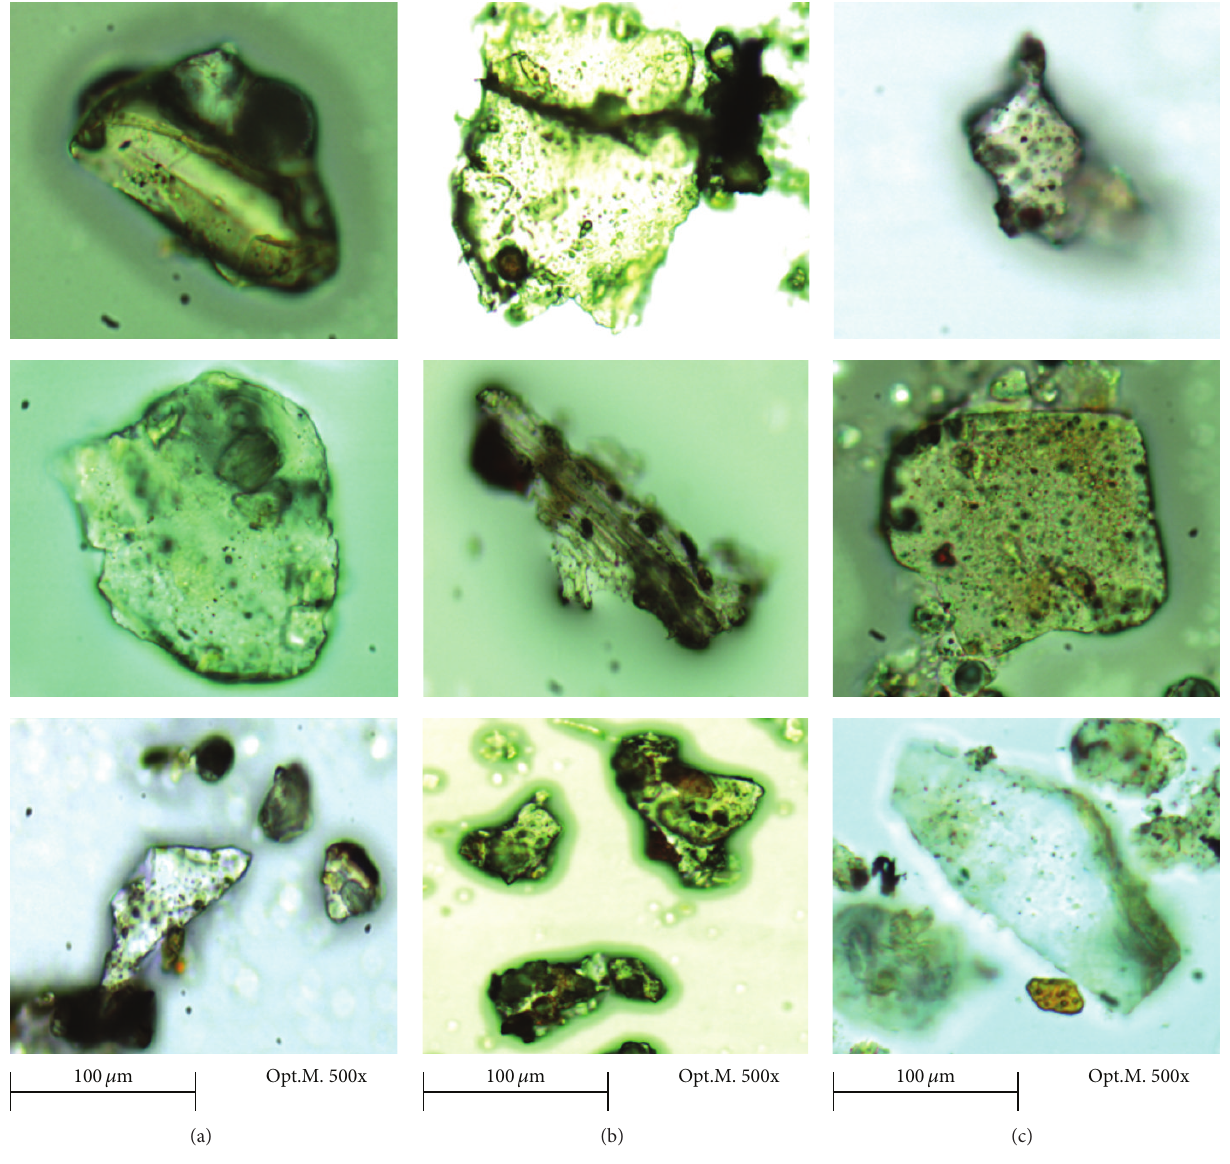
Figure 2: Wear particles’ images